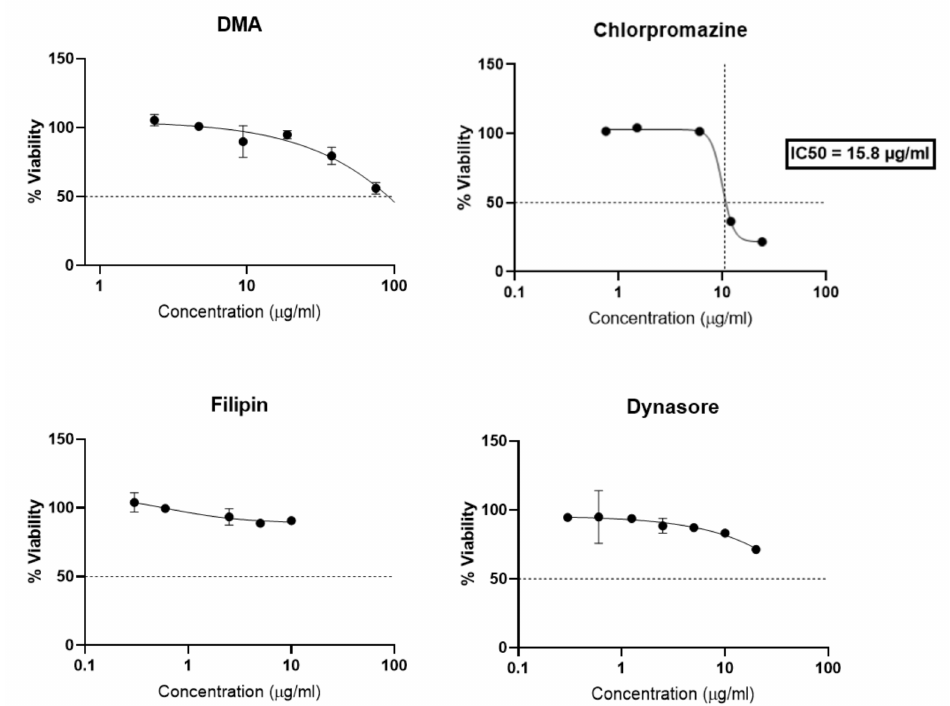
Figure 6. Dose-response curves expressing the viability of BeWo cells after incubation with inhibitors endocytosis (DMA, Chlorpromazine, Filipin, Dynasore) for 4 h. The data represent the results of MTT assay and are expressed as average % cell viability ± SEM against the concentration of the liposomes in mM. Error bars indicate standard deviation for n = 3